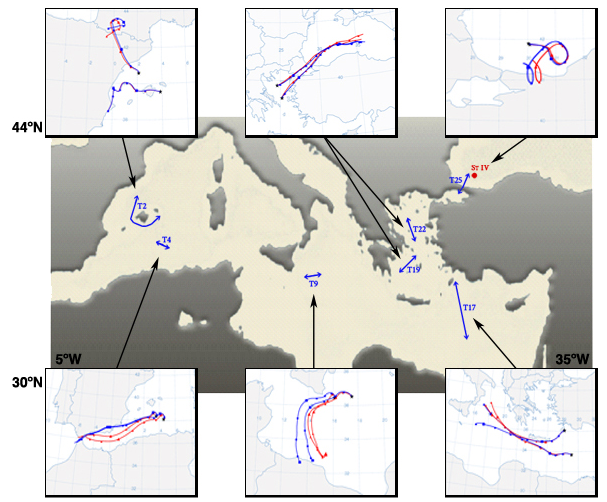
Figure 4. Air mass back-trajectories (48h) of selected samples at two different heights (15m in red and 100m in blue) obtained with the HYSPLIT model. Upper panels’ back-trajectories correspond to samples with the higher PCB concentrations (T2, T19, T22, T25, STIVa, STIVb and STIVc) whereas the lower panels correspond to air masses with lower C G (T4, T9 and